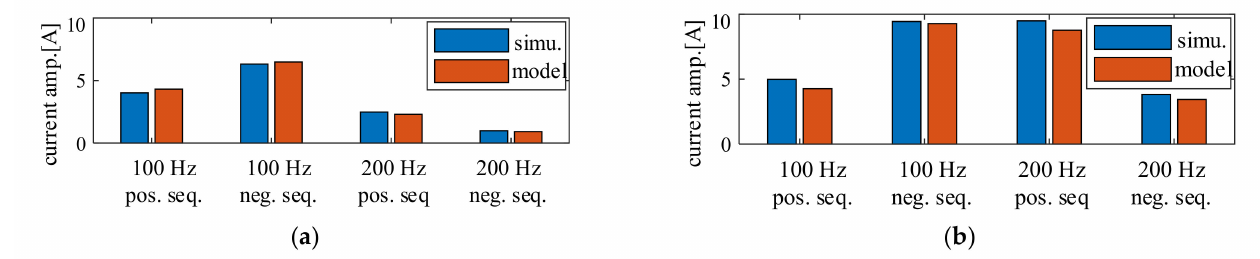
Figure 7. Comparison of Dominant AC-Side Harmonic Amplitudes Obtained with Electromagnetic Transient Simulation and the HSS Model with Different DC perturbation currents. ( a ) Injection of DC perturbation current with 50 A/150 Hz, ( b ) Injection of DC perturbation current with 20 A/200